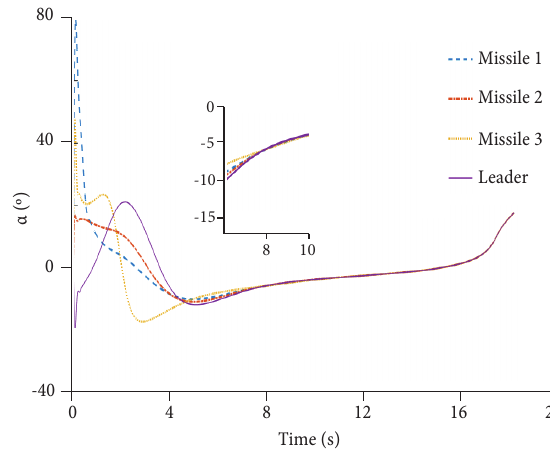
Figure 6. AOA curves of the interceptors obtained using the improved cooperative control strategy.